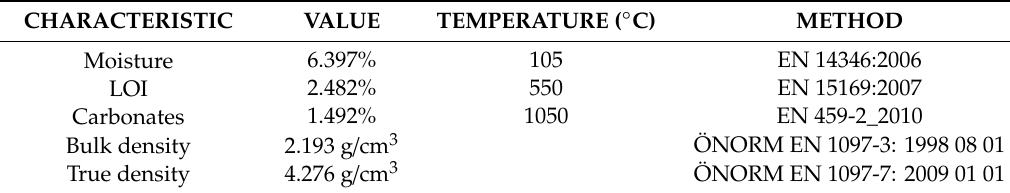
Table 8. Physical analysis of SIDENOR combustion chamber dust samples.